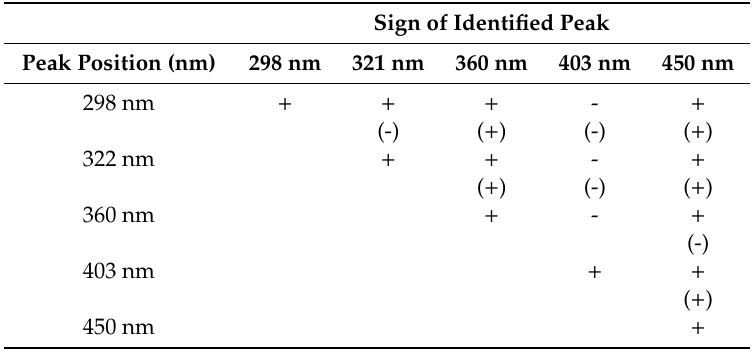
Table 1. The results of two-dimensional correlation spectroscopy (2DCOS) analysis of synchronous fluorescence spectra during milk coagulation: peak assignments and the signs of the cross-peaks in synchronous spectra and asynchronous spectra (shown in